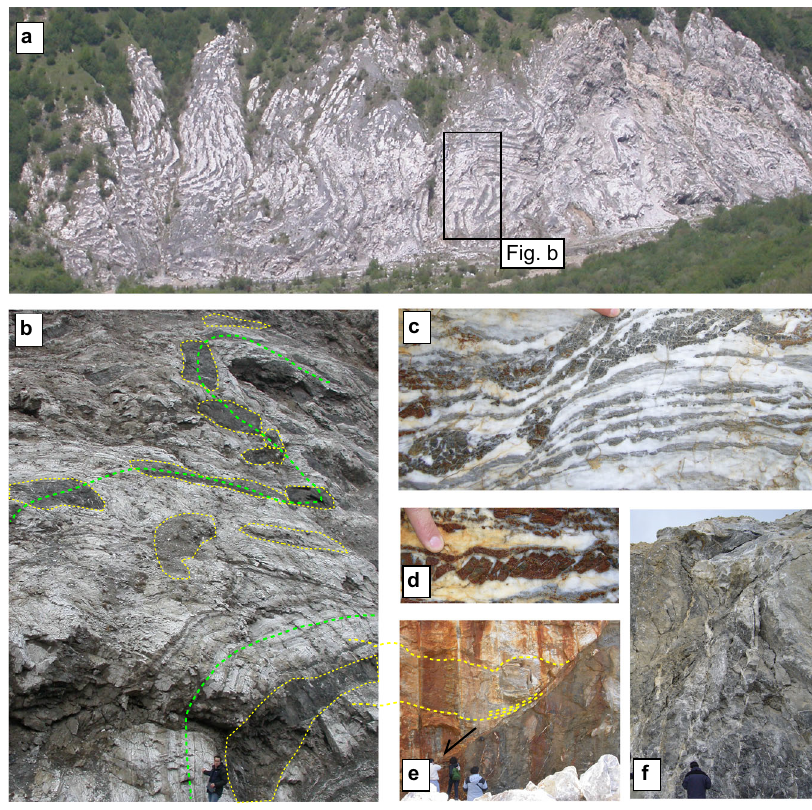
Fig.4|BimodalstyleofdeformationofTriassicEvaporites,TE.a , b Foliatedand folded gypsum/anhydrite rocks (white) with boudinaged dolostone (grey lenses highlighted by dashed yellow lines). The dashed green line marks the geometry of thefolds. c Gneissictransposedfabricaffectedbynormalfaultingandboudinageof the dolostone layers. d Domino-like structure with brittle faulting on dolostones